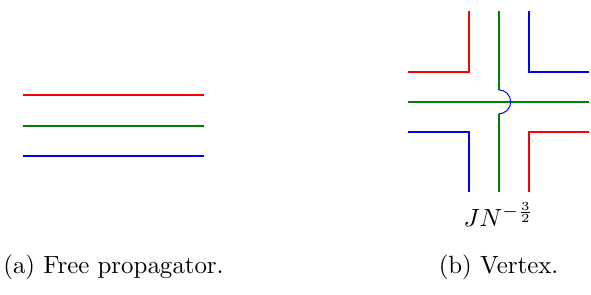
Figure 2. Free propagator and vertex in the KT model.